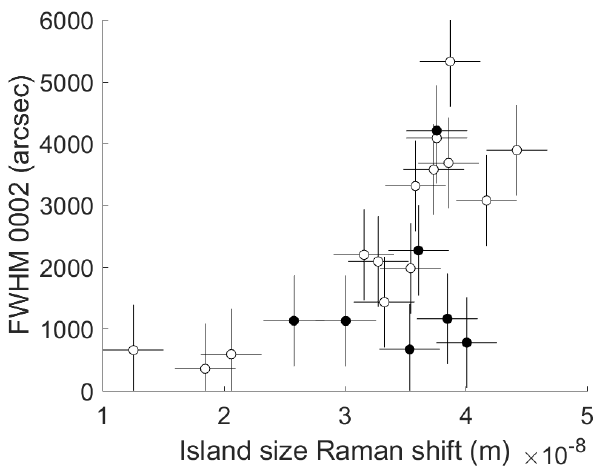
Figure 5. Nucleation island sizes deduced from Raman shift versus crystal quality. Full dots indicate sample with cracks. Standard deviation is indicated.